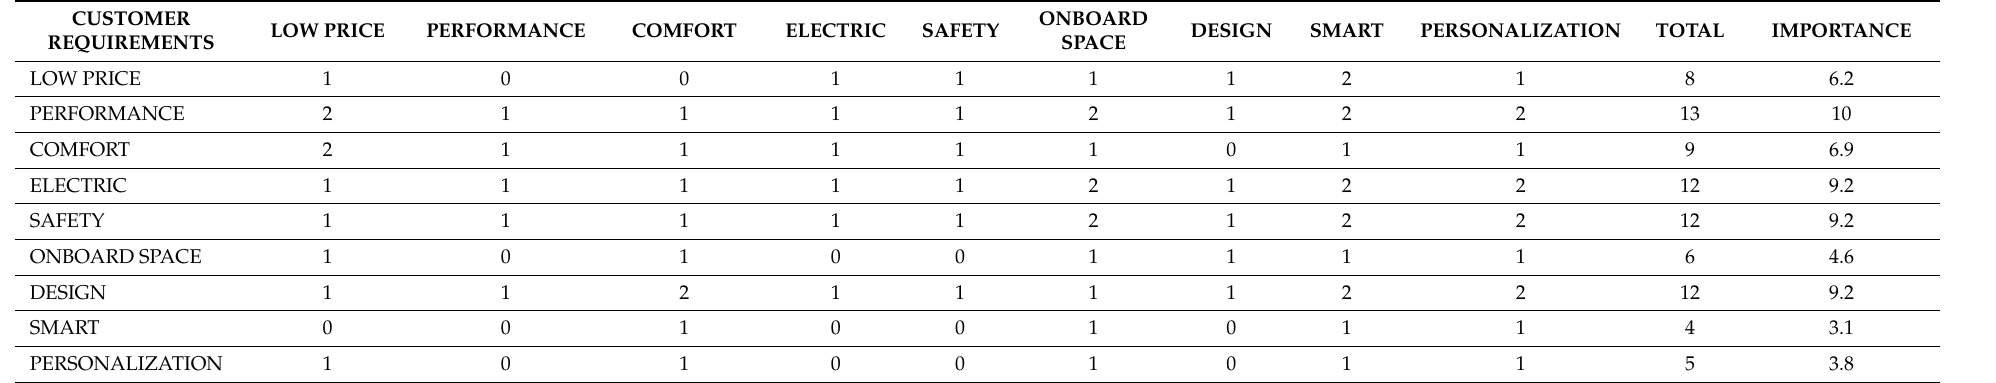
Table 4. Relative Importance